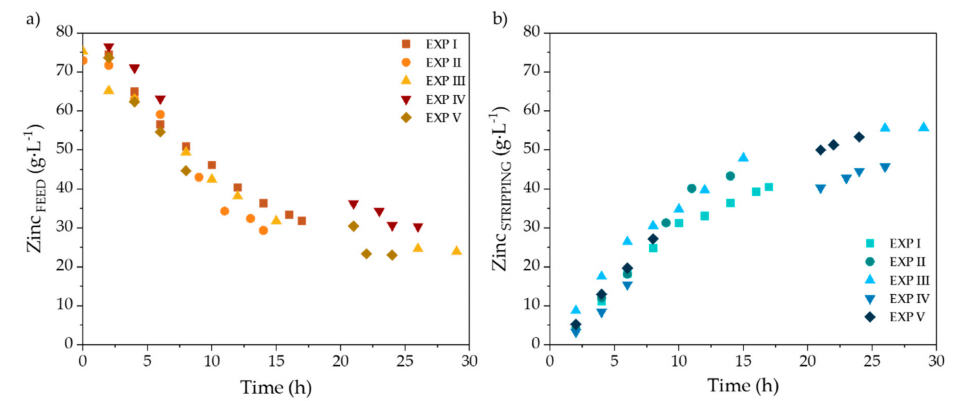
Figure 3. Zinc concentration in the feed phase ( a ) and in the stripping phase ( b ) with experimental time for EXP